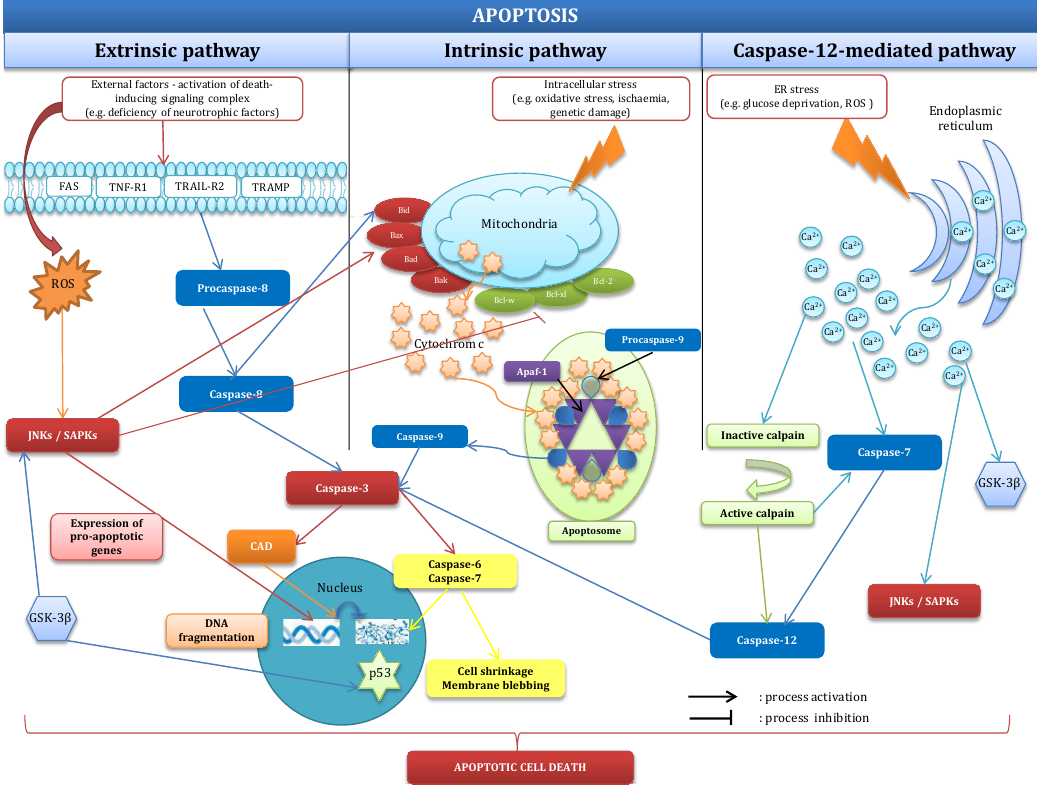
Figure 1. Mechanisms of apoptosis. Apoptosis has been classified as external, internal, and caspase-12-dependent processes. Additional details have been provided in part 2.1. CAD: caspase-activated DNase; GSK-3 β : glycogen synthase kinase 3 beta; ROS: reactive oxygen species; JNK: c-Jun N-terminal kinase; SAPK: stress-activated protein